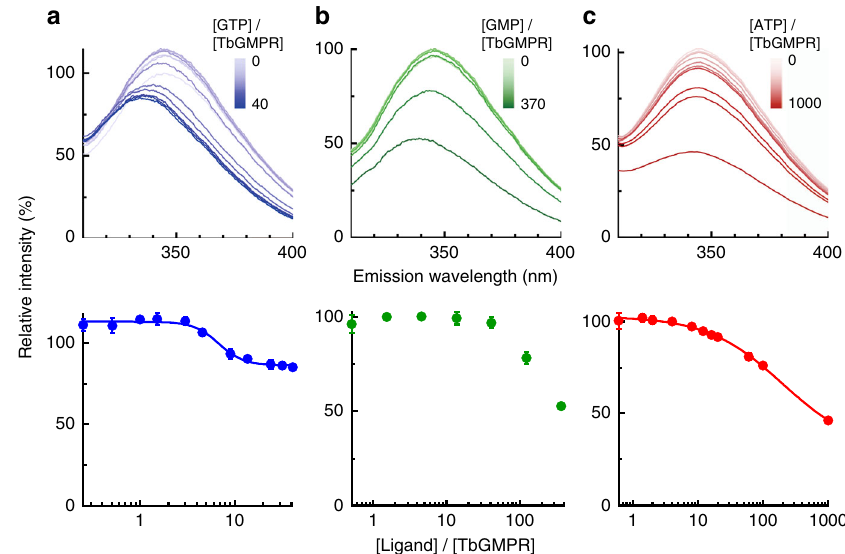
Fig. 2 Tryptophan fl uorescence quenching of TbGMPR W115R by purine nucleotides. a – c ( Upper panels ) The fl uorescence emission spectra of Trp120 in TbGMPR W115R. GTP ( a ), GMP ( b ), and ATP ( c ) were used as ligands. a – c ( Lower panels ) The peak value of each plot was re-plotted against the ratio of the ligand to protein concentration shown in logarithmic scale. Plots were fi tted to the Hill equation. Data were obtained from three independent experiments ( n = 3). Each data point represents a mean ± s.d. in error bars. Source data are provided as a Source Data fi